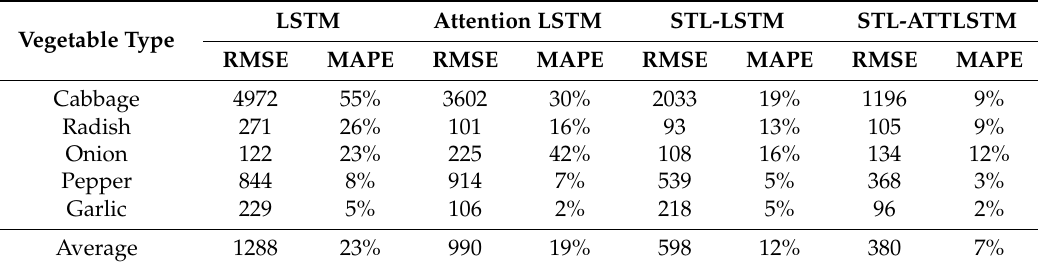
Table 6. Prediction accuracy measures of proposed model and